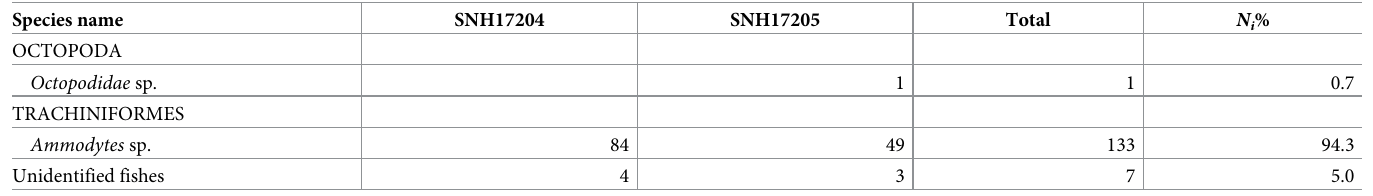
Table 4. Stomach contents of two harbour porpoises that became entangled in a bottom gillnet off Rausu, Hokkaido, Japan. Species